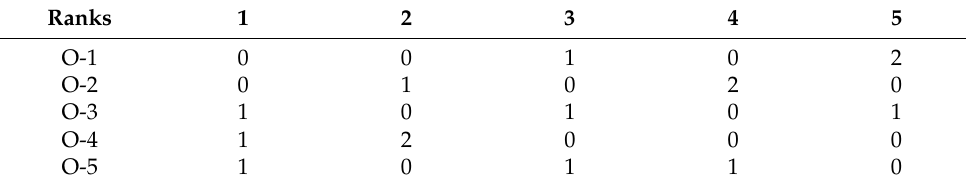
Table A6. Frequency of ranks according to